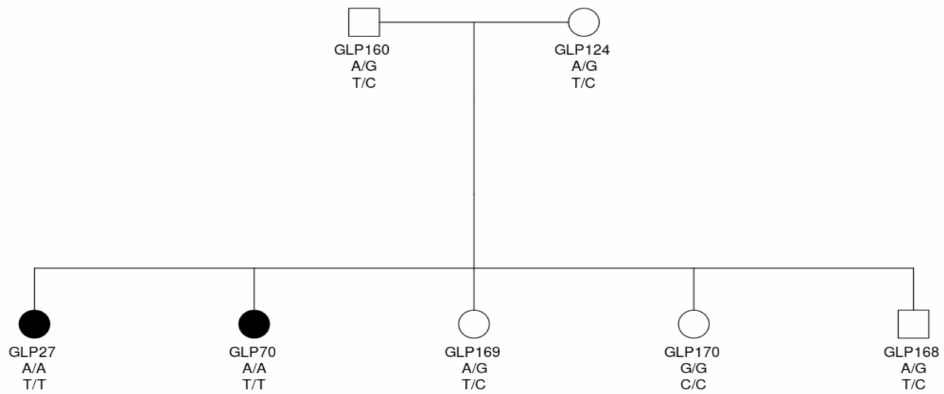
Figure 3. Genotypes of dogs suggesting a recessive trait of the disease. A circle denotes a female dog and a square denotes a male dog. Black background indicates that the dog is